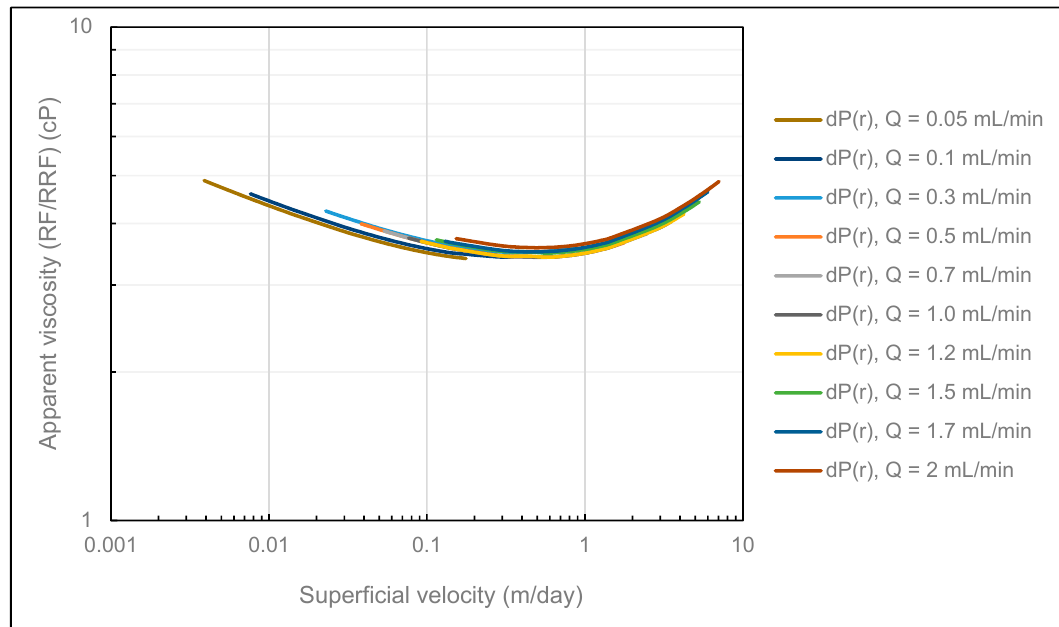
Figure 8. Polymer in situ rheology obtained using the DMM.